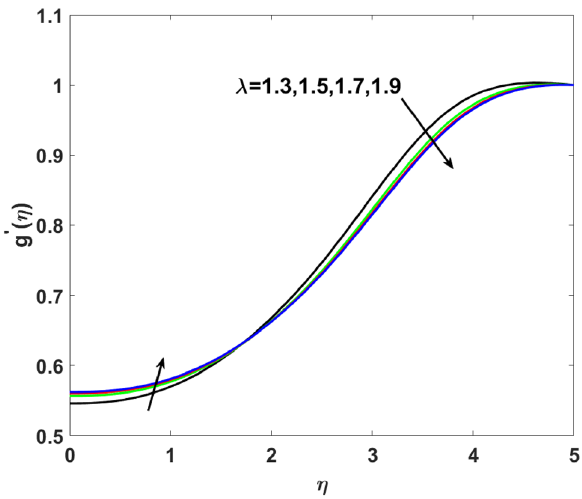
Figure 6. g ′ (η) versus (cid:31) .